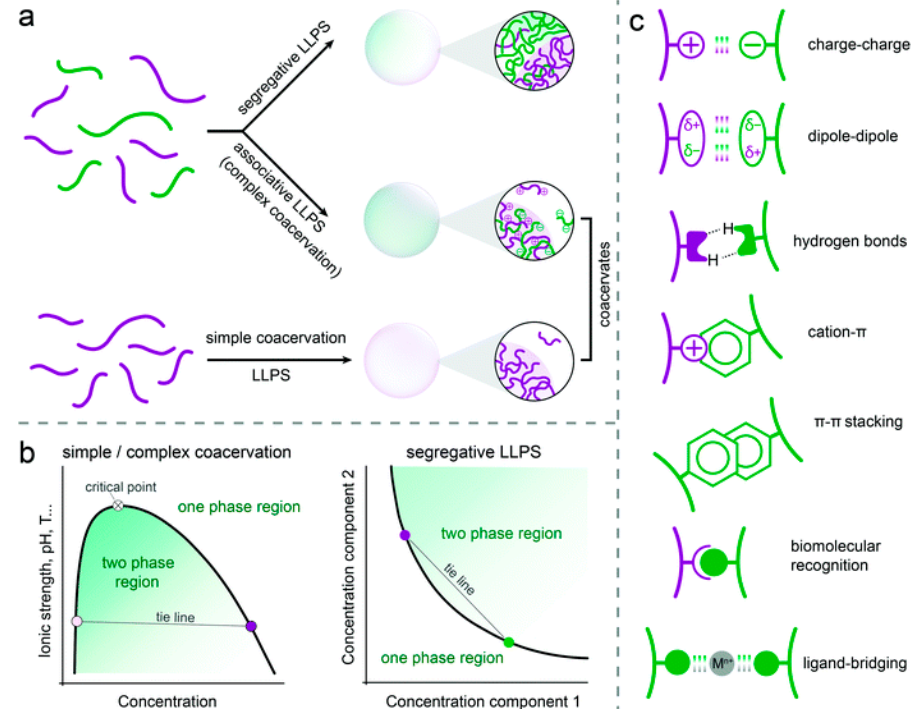
Figure 12. ( a ) Types of liquid–liquid phase separation (LLPS) and the formation of coacervates, ( b ) schematic phase diagrams of simple or complex coacervation and segregative phase separation, ( c ) possible interactions involved in the formation of peptide-based coacervates. Reprinted from Chem-